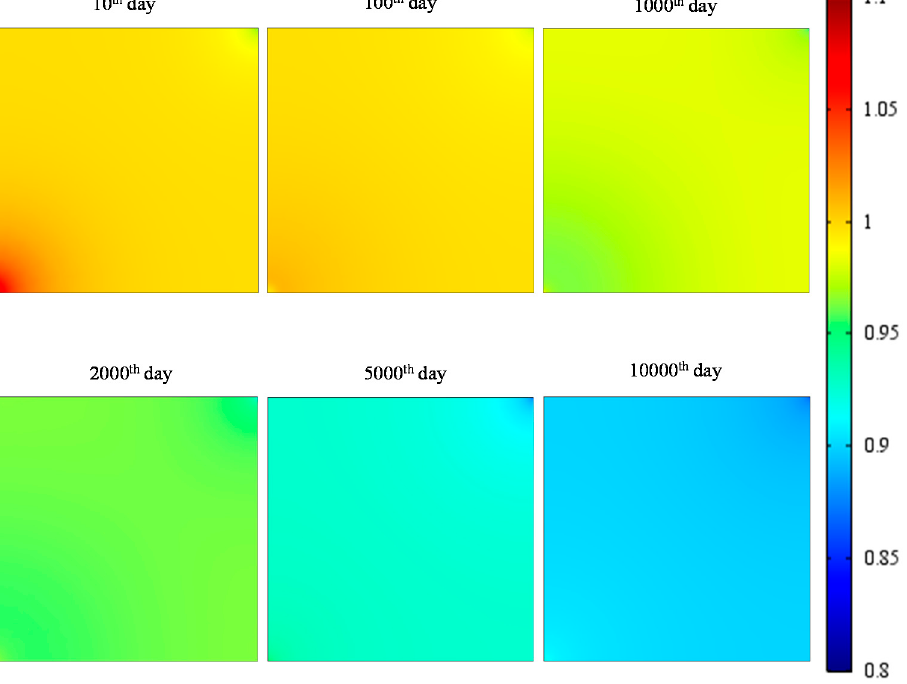
Figure 5. Fracture permeability evolution maps ( k f / k f 0 ) at different time.